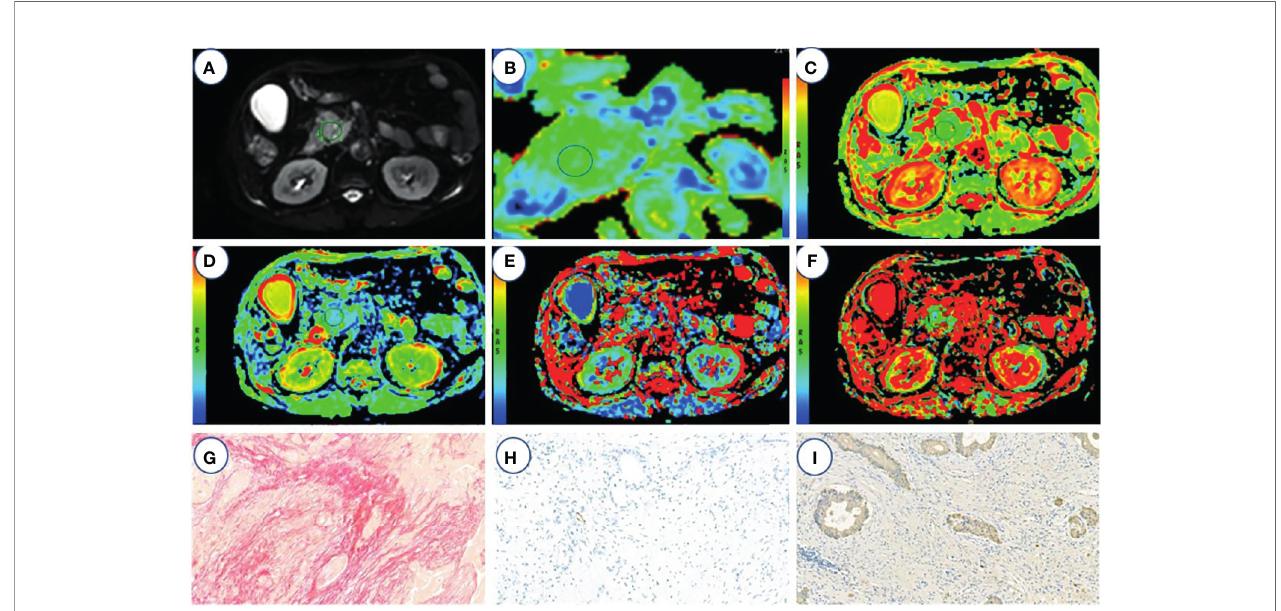
FIGURE 2 | A 67-year-old male with high fi brosis PDAC. (A – F) represents the DWI, ADC(0,500), ADC(0,800), D, f, and D* values map, respectively. (G – I) represents the fi brosis, microvascular density, and tumor cell dyeing map, respectively. ROI was set in PDAC on DWI, ADC (0, 500) , ADC (0, 800) , D, f, and D* value maps. The cancer tissues show different signals from normal tissues in the DWI, ADC (0,500) (1.3 m m 2 /ms), ADC (0,800) (1.2 m m 2 /ms), D (1.16 m m 2 /ms), f (18.03%), and D* (64.5 m m 2 /ms). Fibrosis, MVD, and tumor cell are 47, 1.3, and 21%, respectively.